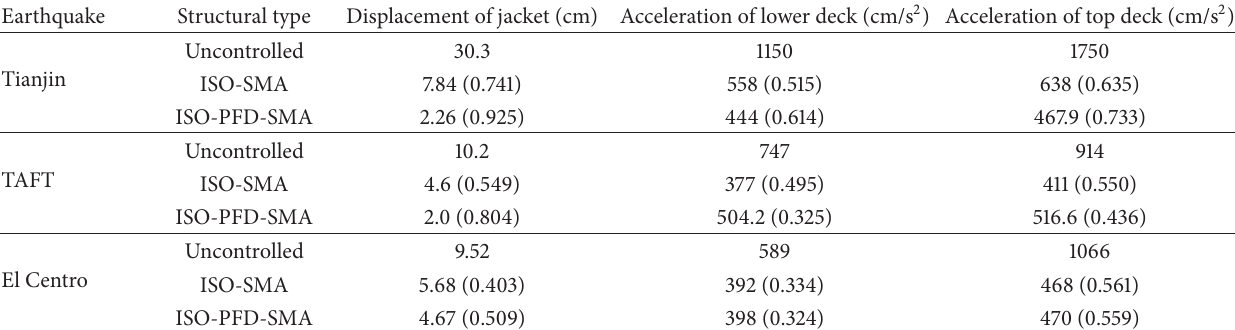
Figure 9: Computational response of JZ20-2MQU model under El Centro earthquake excitation. Table 4: Maximum test results of earthquake excitation of the